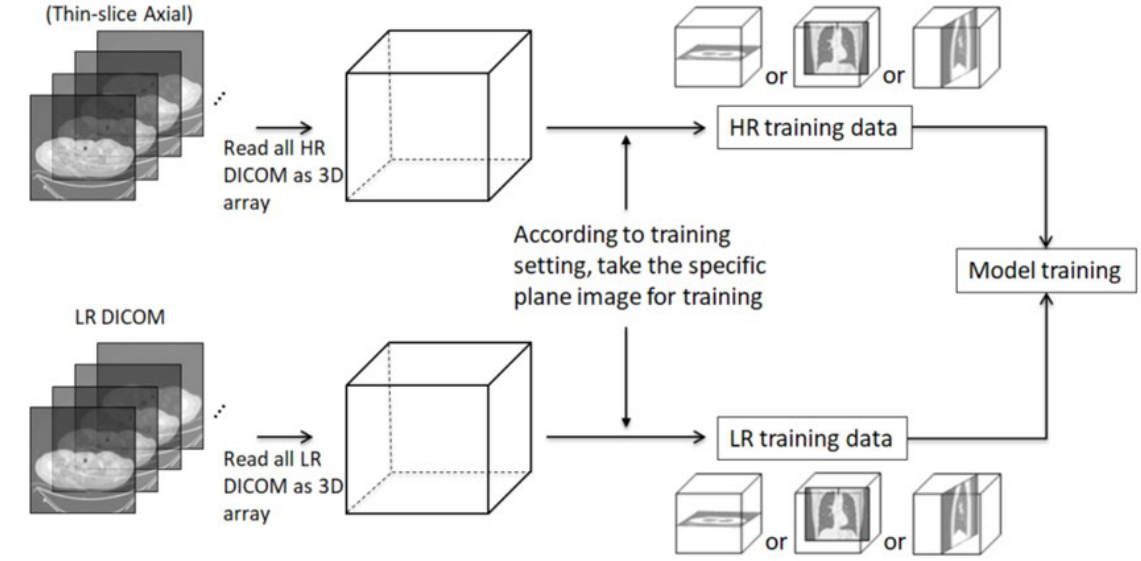
Figure 6. Diagram of model training for a specific plane. After the HR and LR images were selected, we cropped random 96 × 96 pixel patches from the images. SRCNN, VDSR, SRResNet, and EDSR were trained using different parameters according to our training experience. The type of loss function was selected